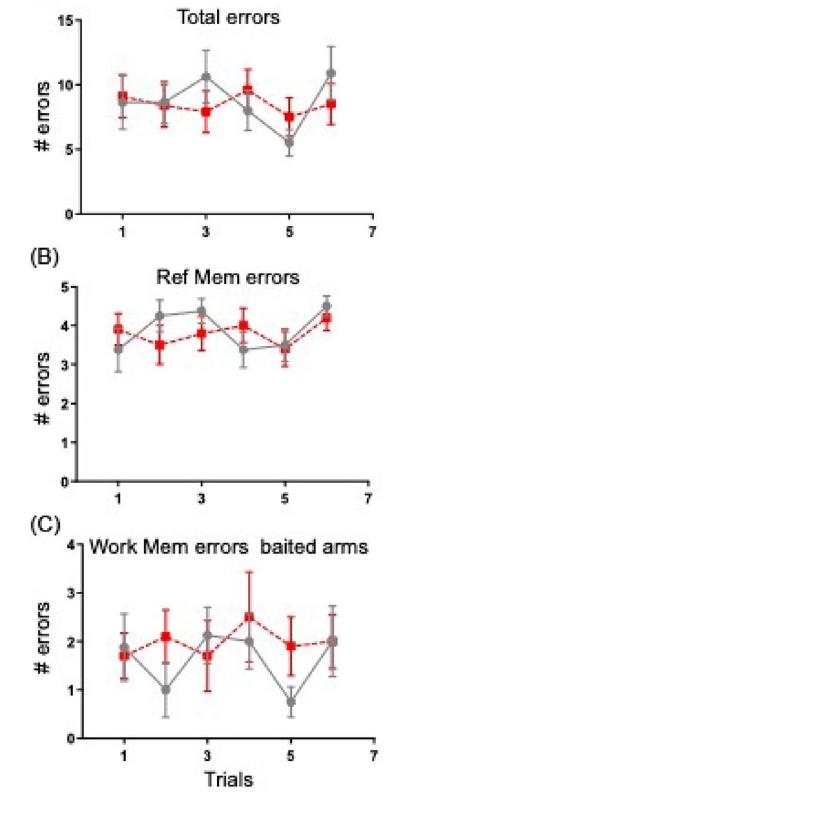
Figure 1. Number of errors made during one day of spatial discrimination task. Illustrated are: total errors ( A ), Reference Memory Errors ( B ) and Working Memory errors ( C ) made during 6 consecutive trials. Notice lack of difference in the performance between the WT (black curve) and TG (red curve)